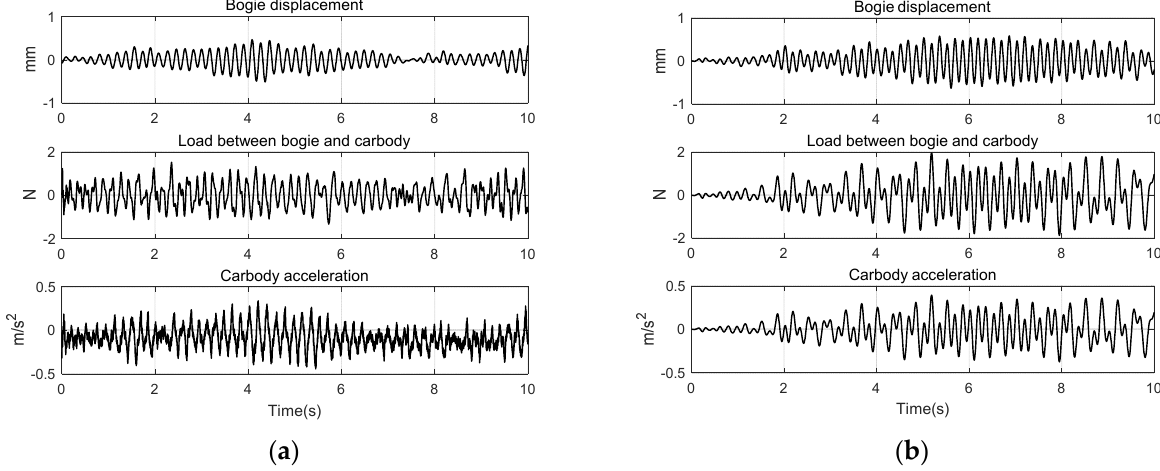
Figure 8. Dynamic characteristics in lateral direction: ( a ) experiment, ( b ) simulation. For clarity, all the time history signals obtained from the experiments and simulations are transformed into the frequency domain and, thereafter, superimposed together in Figure 9. All the frequency plots, either for the vertical or lateral direction, reveal that the amplitude transformed from the experimental data is smaller than that from the simulation data. In addition, the experimental peak frequencies are higher than the simulation peak frequencies in the vertical direction frequency plots, and vice versa for the lateral direction frequency plots. Table 4 summarizes the quantitative differences between the experimental and simulation